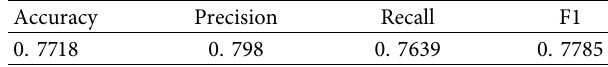
Table 4: Evaluation index table of K -nearest neighbor